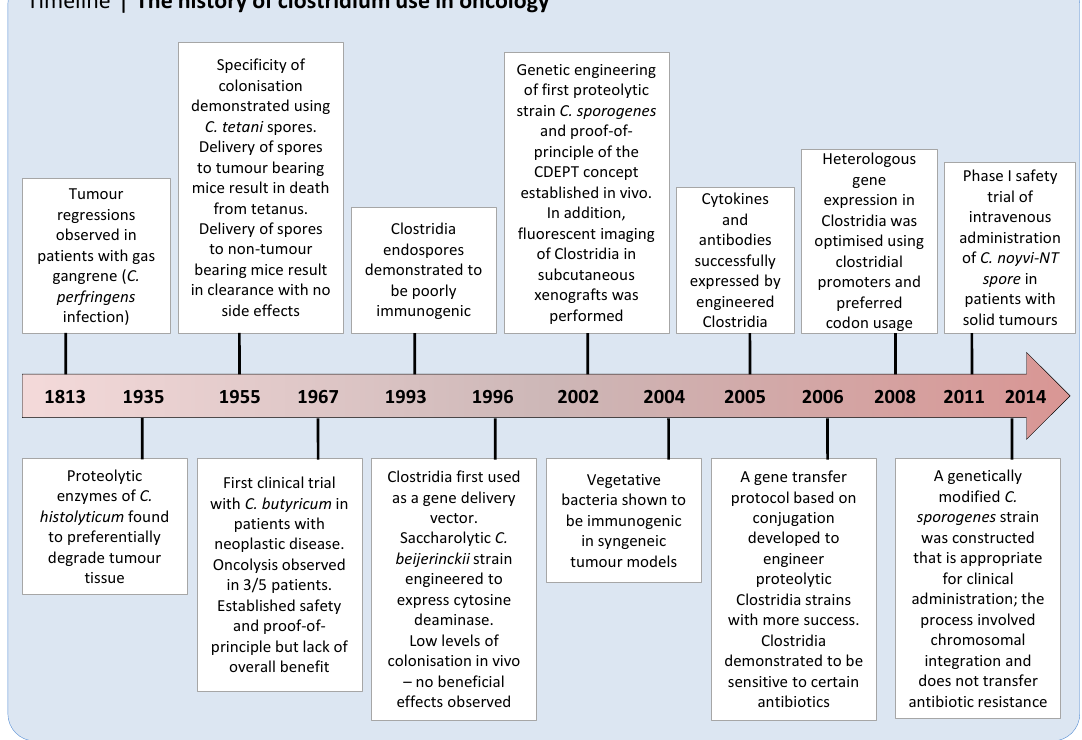
Figure 2. Key (pre)clinical steps in clostridial use and development. CDEPT, Clostridium Directed Enzyme Prodrug Therapy.